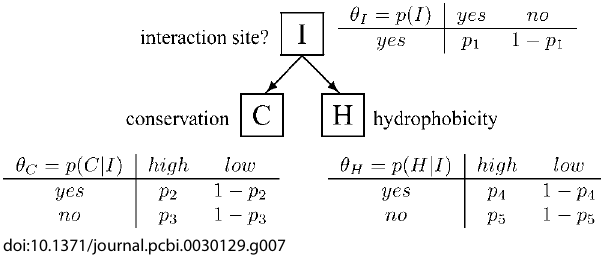
Figure 7. Naı¨ve Bayes Classifier with Model Parameters in the Form of